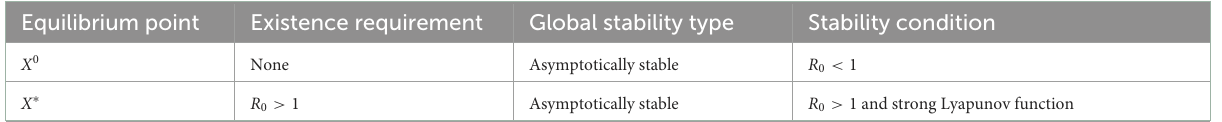
TABLE 2 Stability conditions. Equilibrium